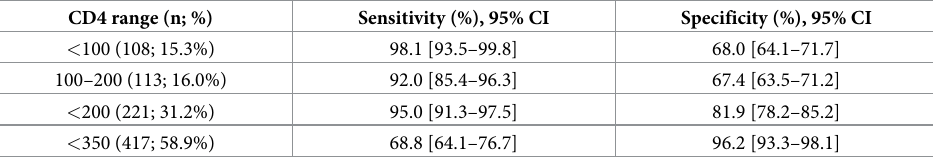
Table 3. Diagnostic performance of Visitect CD4 LFA at different CD4 cut-offs of the reference test. CD4 range (n;